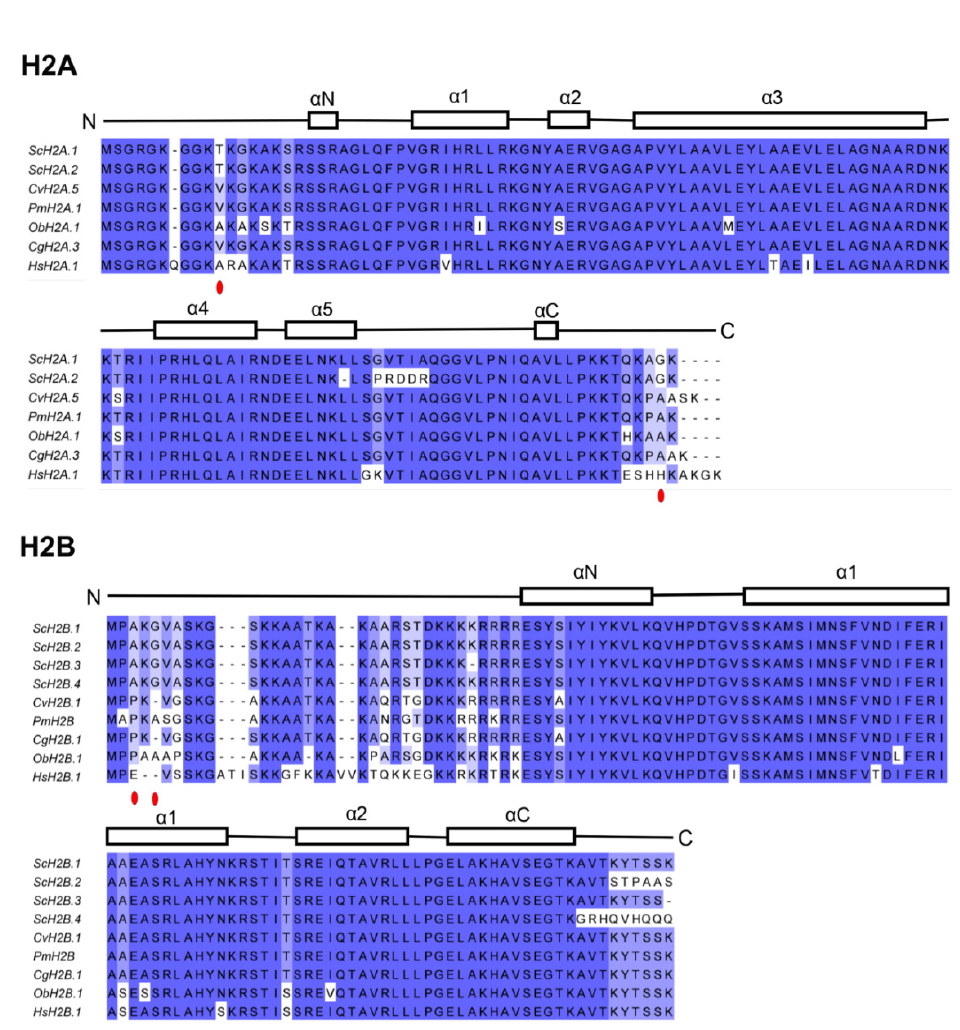
Figure 2. Multiple sequence alignment of core H2A and H2B amino acid sequences from selected molluscs and human. Percent similarity is shown in blue, while the intensity of the color corresponds to the degree of similarity. The amino (N) and carboxy (C) terminal ends as well as the predicted secondary structure are shown above the alignment. Unique amino acids that varied in S. constricta in comparison to the other molluscs are marked by red ovals below the alignments. Table 3. Number of histone genes for each group among